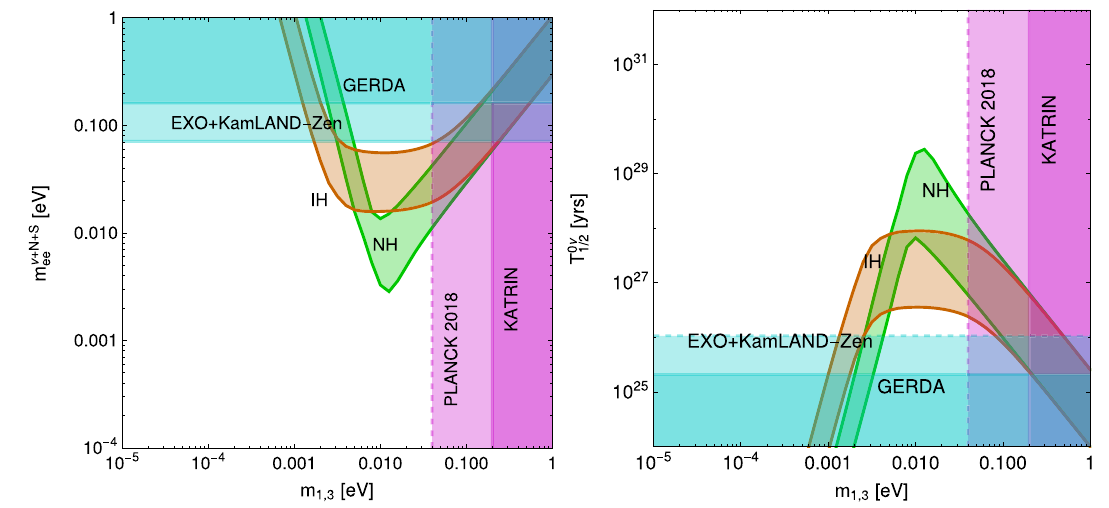
Fig. 9 Effective Majorana mass (left panel) and half-life (right panel) as a function of lightest neutrino mass m 1 ( m 3 ) for NH (IH) due to the combined contributions of standard mechanism, N R and S L mediated diagrams